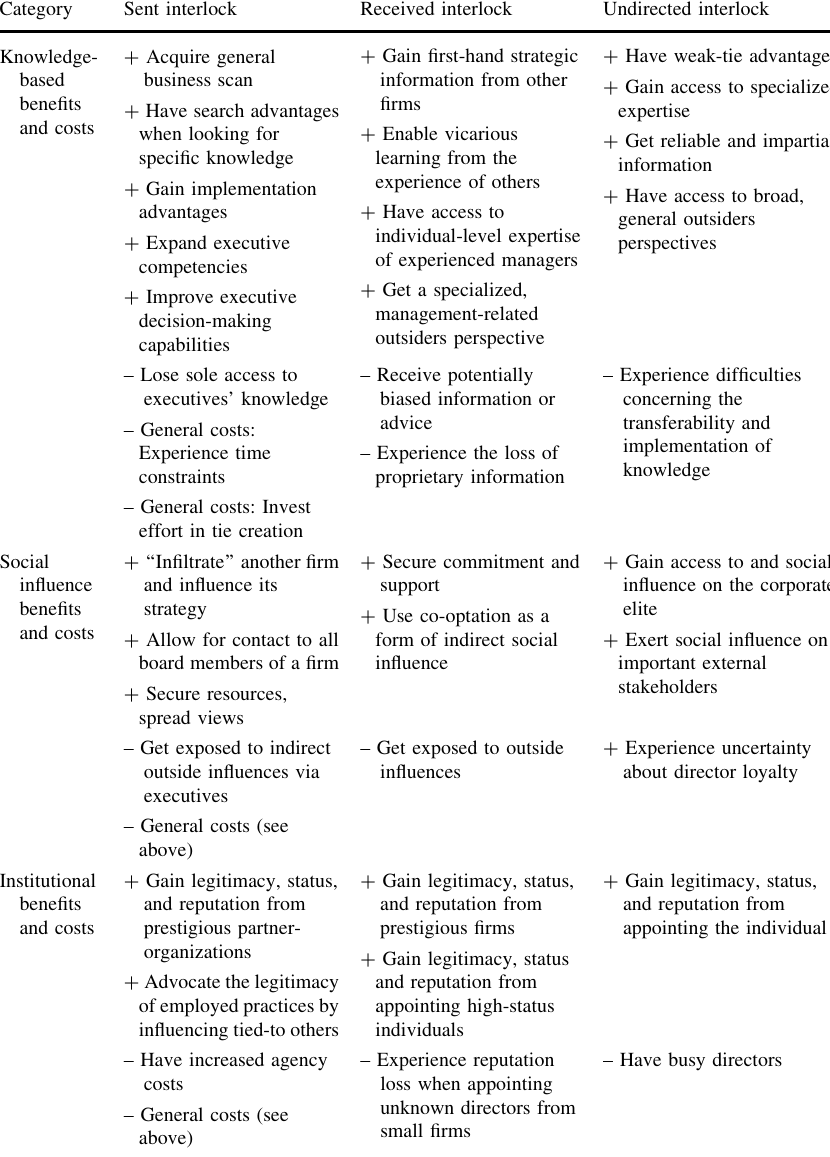
Table 1 Focal firms’ benefits and costs of sent, received, and undirected interlocks